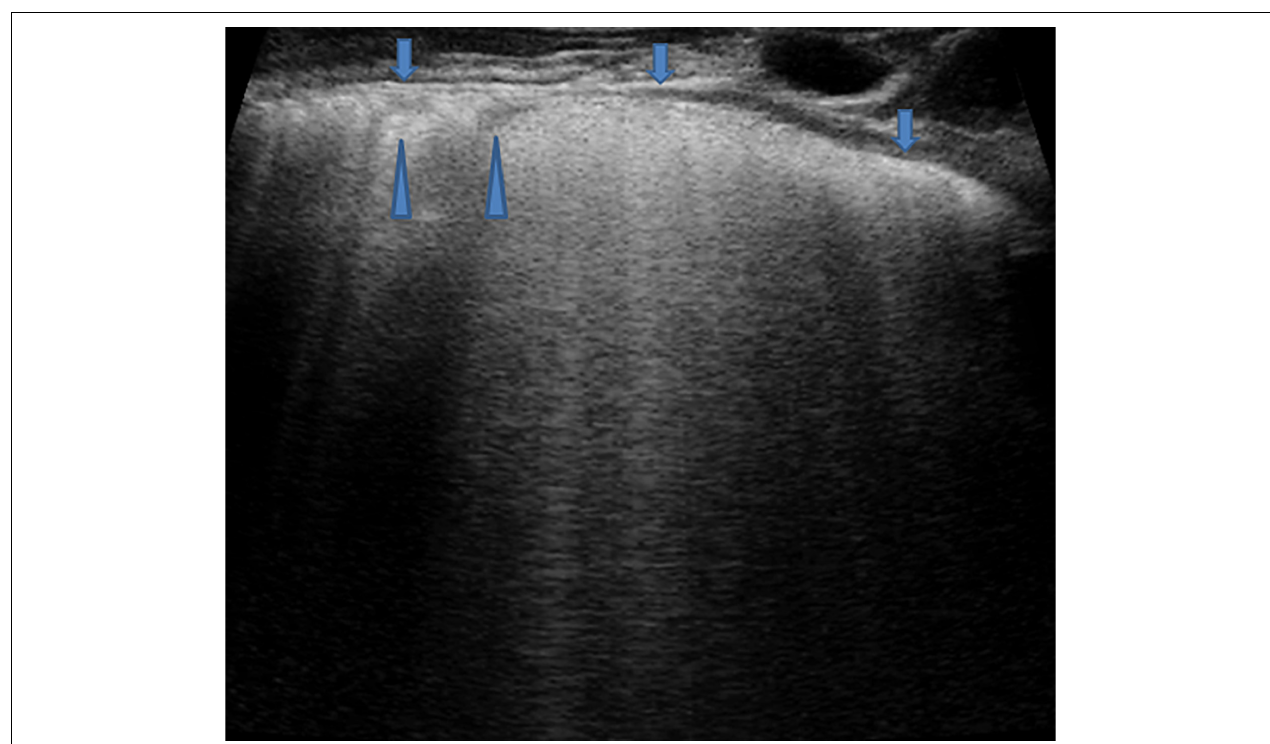
FIGURE 9 | Grayscale lung ultrasound examination (transverse scan between intercostal fields; linear probe with 12 MHz frequency) of a 4-year-old boy with viral pneumonia – due to Coronavirus (non-COVID-19), Bocavirus, and Metapneumovirus coinfection- requiring respiratory assistance with High- flow nasal oxygen at the pediatric department. It shows sonographic interstitial syndrome (SIS) which is characterized by blurred, uneven, coalescent B-lines and white lung; irregular pleural line (arrows); reduced pleural sliding; multifocal inhomogeneous involvement; subpleural microconsolidations (generating pseudo-B-lines)